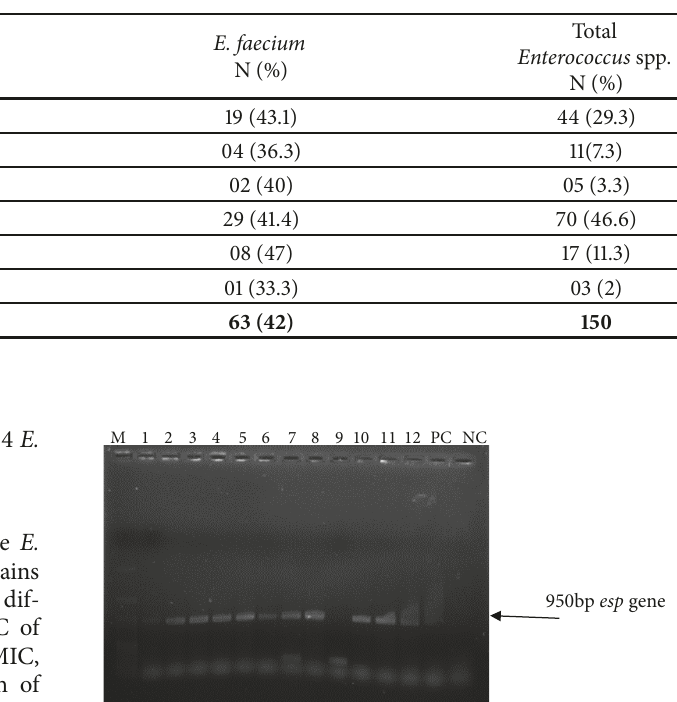
Table 1: Enterococcus spp. isolated from different clinical samples.